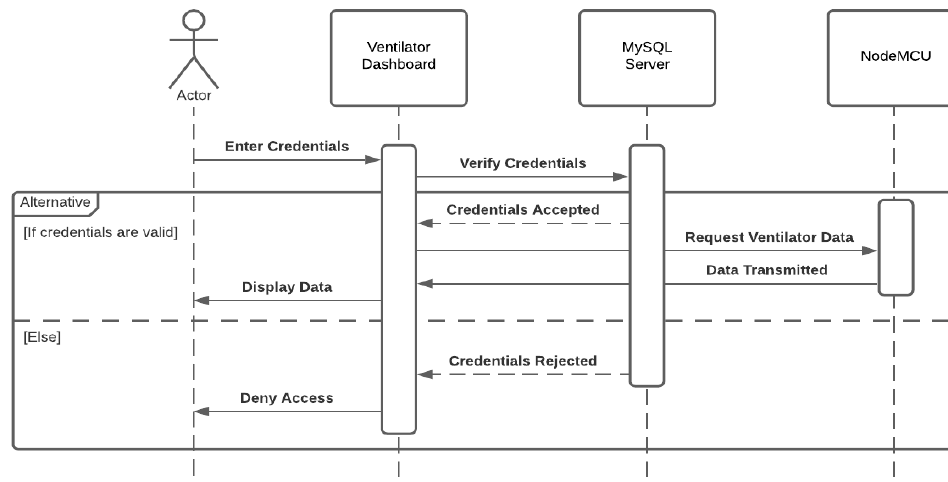
Figure 2. Normal scenario—communicating with a ventilator.